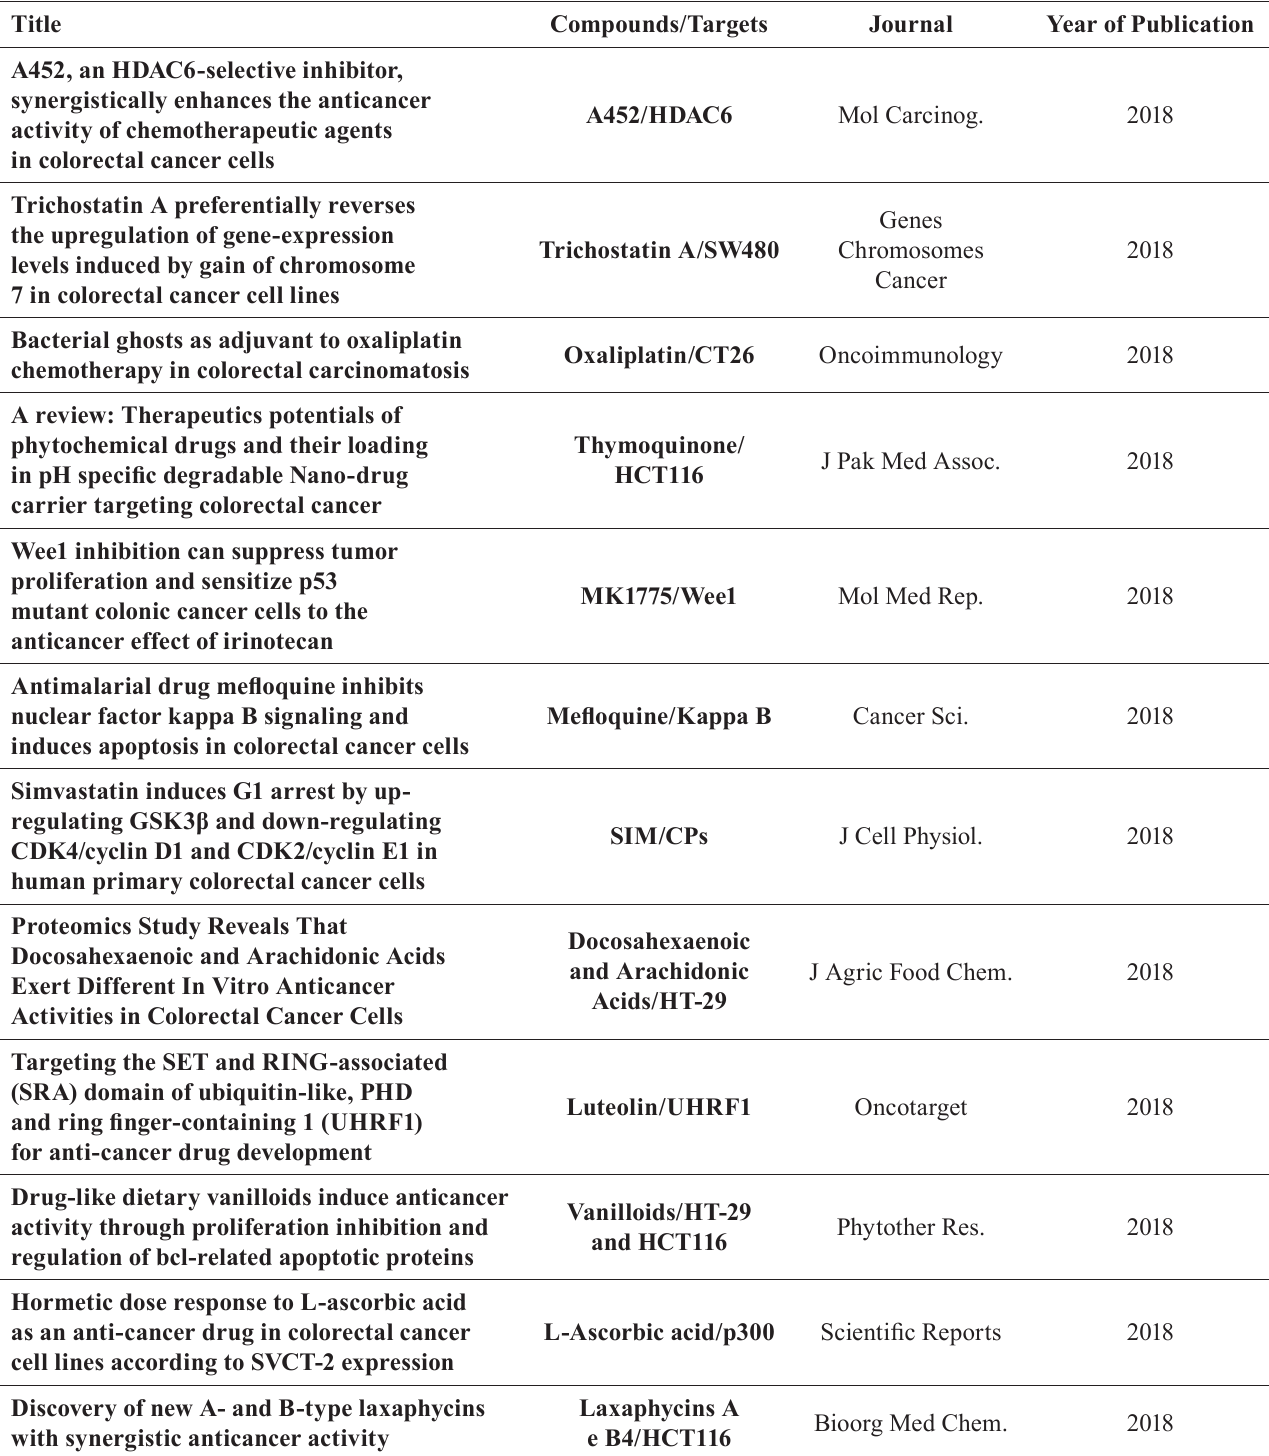
TABLE II – Potential CRC-related drugs identified in PubMed articles, followed by related tumor targets and their